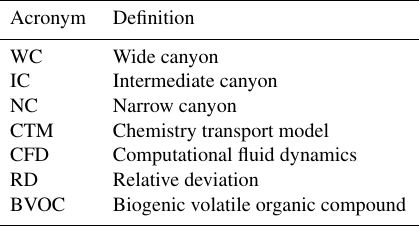
Table A1. List of